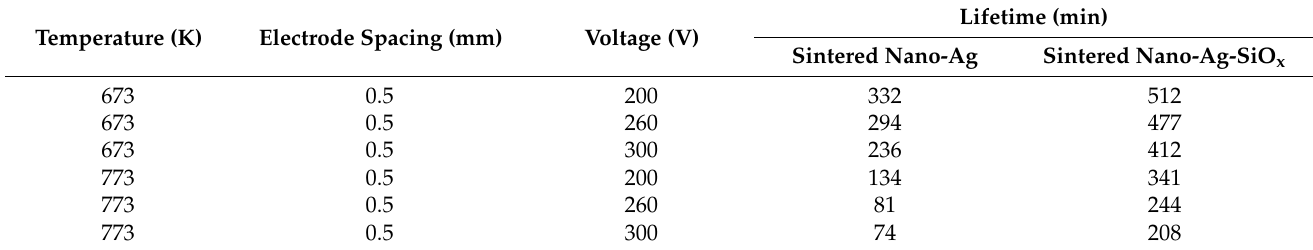
Table 1. ECM testing conditions and lifetime